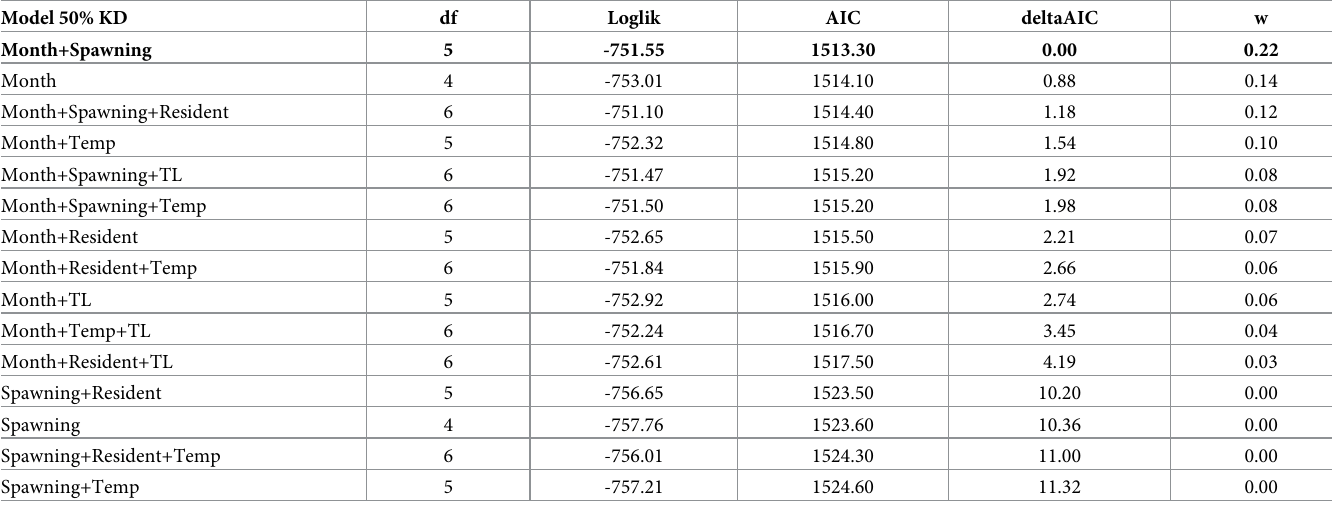
Table 2. The 15 top-ranked GLMMs for the 50% Kernel Density (KD) activity